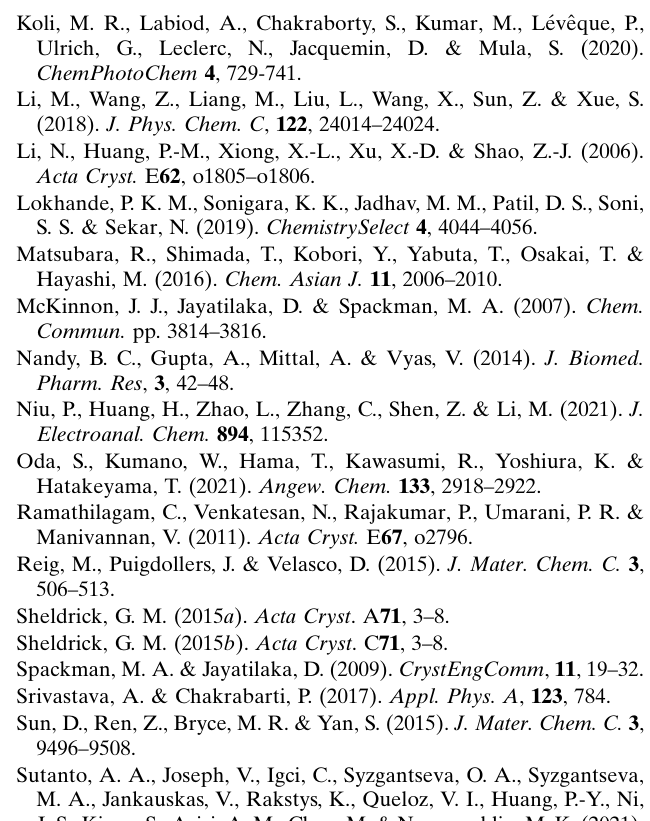
geometrically (C—H = 0.95 A˚ ) and refined as riding with U (H) = 1.2 U (C). iso eq